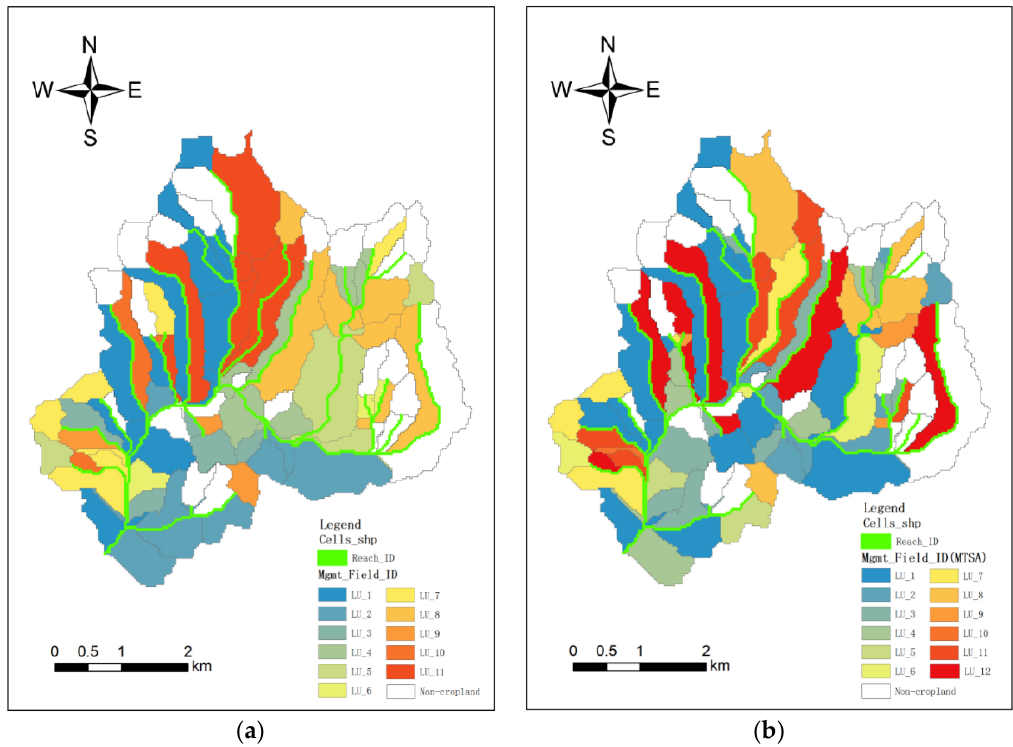
Figure 5. Initial ( a ) and optimal ( b ) land use structure for the Peiqiao River watershed.